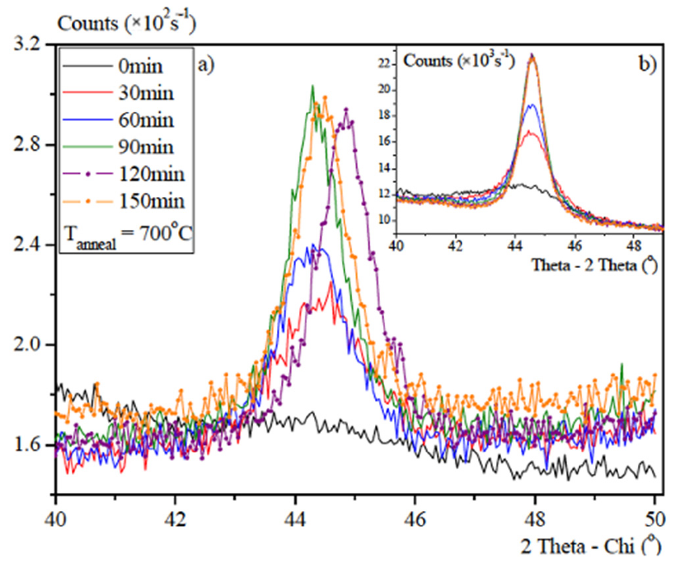
Figure 2. Representative XRD patterns of the Ni 2 MnAl(220) peaks measured by ( a ) IP and ( b ) OP configurations.